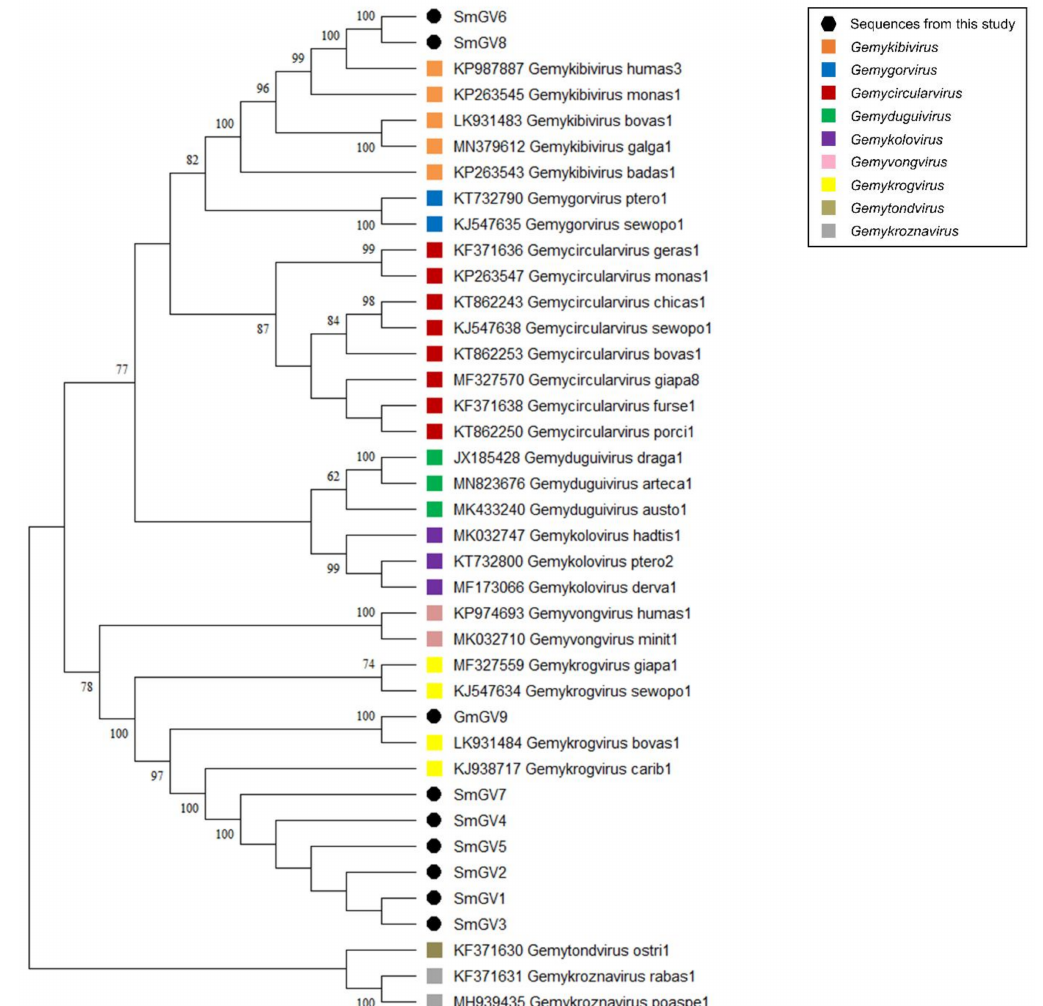
Figure 2. Maximum Likelihood phylogenetic tree of representative sequences from nine genomoviral genera and genomovi- ral sequences from this study. The evolutionary history was inferred by using the Maximum Likelihood method and Tamura-Nei model [37]. The bootstrap consensus tree inferred from 500 replicates is taken to represent the evolutionary history of the taxa analyzed [38]. Branches corresponding to partitions reproduced in less than 50% bootstrap replicates are collapsed. The percentage of replicate trees in which the associated taxa clustered together in the bootstrap test (500 repli- cates) are shown next to the branches [38]. Branch support values lower than 60% were not included. This analysis involved 39 nucleotide sequences. There were a total of 3641 positions in the final dataset. Evolutionary analyses were conducted in MEGA software. All taxa are indicated by name and the corresponding GenBank accession number. Table 2. Summary of conserved motifs in genomoviral sequences after intron clearing and in silico translation.